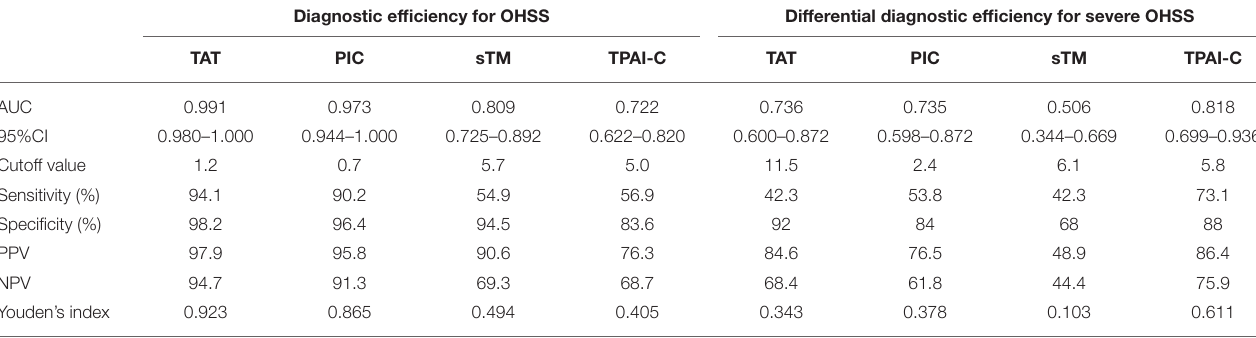
TABLE 2 | Evaluation of thrombin-antithrombin complex, plasmin alpha2-plasmin inhibitor complex, soluble thrombomodulin, and tissue plasminogen activator-inhibitor complex efficiency [including the diagnostic efficiency for ovarian hyperstimulation syndrome (OHSS) and the differential diagnostic efficiency for mild–moderate and severe OHSS].